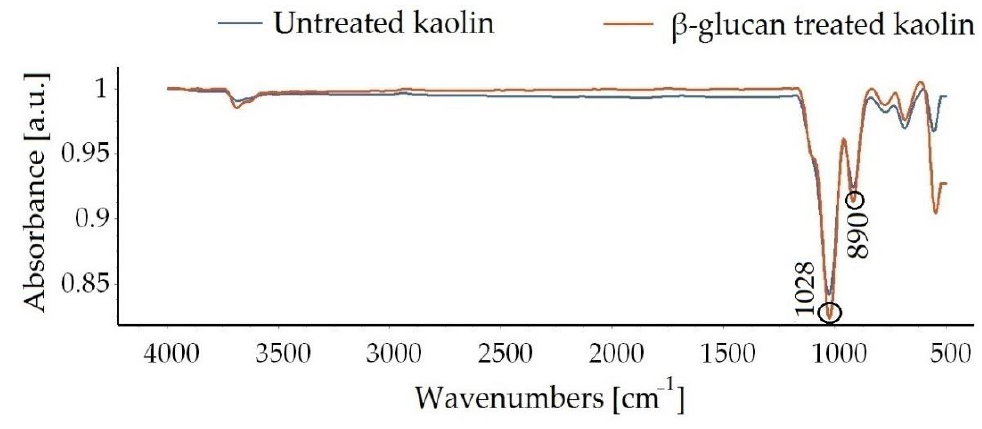
Figure 8. FTIR curves of untreated and β -glucan-treated kaolin clay.